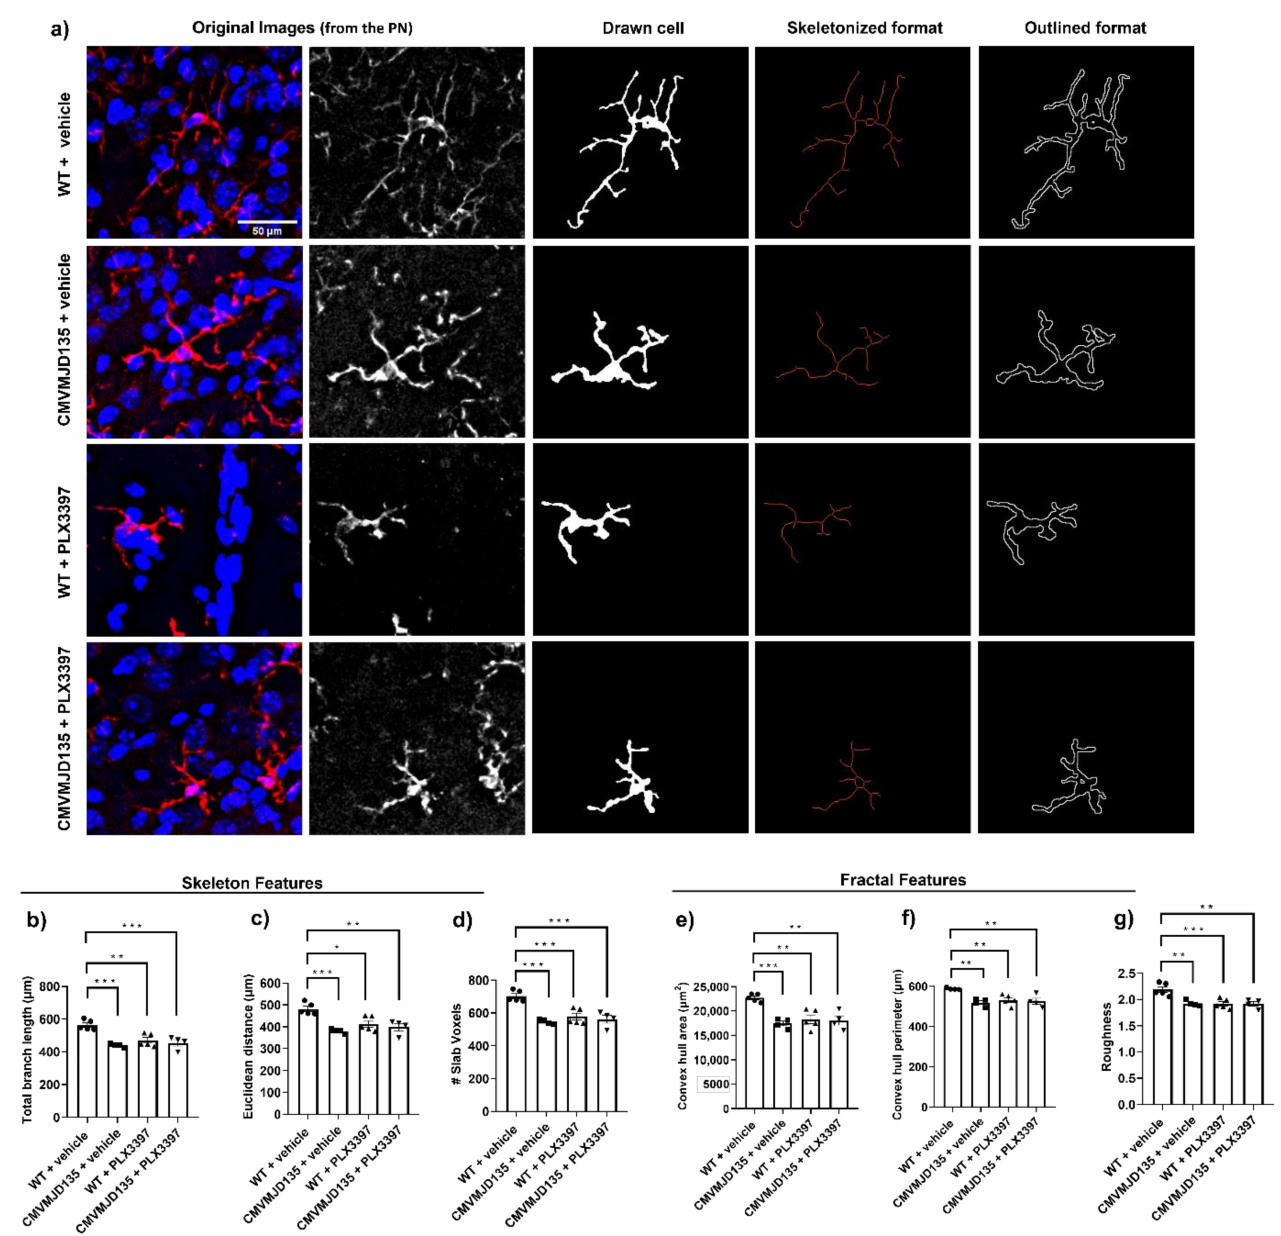
Figure 3. Microglial activation observed in the PN of CMVMJD135 mice, at 21 weeks of age, is not altered by PLX3397 treatment. ( a ) Representation of the process to prepare the images for skeleton and fractal analysis of microglia morphology. Quantification of the morphometric parameters associated to microglia ramification: ( b ) total branch length; ( c ) Euclidean distance; and ( d ) # slab voxels. Associated with cell size: ( e ) convex hull area; and ( f ) convex hull perimeter. Associated with cell surface: ( g ) roughness. Data of all these parameters were obtained from: 210 microglial cells from WT + vehicle mice ( n = 4); 217 microglial cells from CMVMJD135 + vehicle mice ( n = 4); 248 microglial cells from WT + PLX3397 mice ( n = 5); and 235 microglial cells from CMVMJD135 + PLX3397 mice ( n = 5). The symbols • , (cid:4) , (cid:78) , and (cid:72) stand for the WT + vehicle, CMVMJD135 + vehicle, WT + PLX3397, and CMVMJD135 + PLX3397 groups, respectively. Data are presented as mean + SEM (one-way ANOVA (post hoc Tukey’s test)). *, **, ***, represent p < 0.05, p < 0.01 and p < 0.001, respectively. Scale bar 50 µ